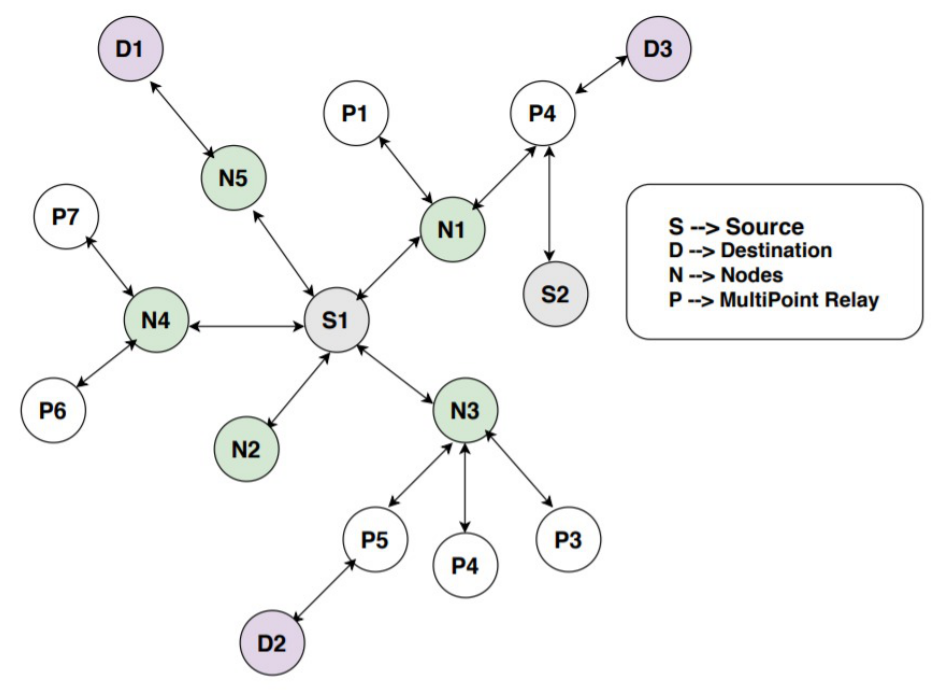
Figure 3. Network